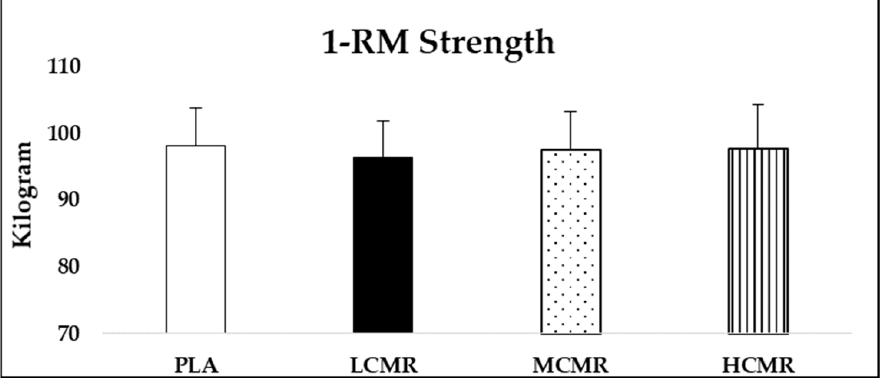
Figure 2. Mean (SD) bench press strength (1-RM) performance. PLA: placebo; LCMR: low dose of caffeine mouth rinse; MCMR: moderate dose of caffeine mouth rinse; HCMR: high dose of caffeine mouth rinse.